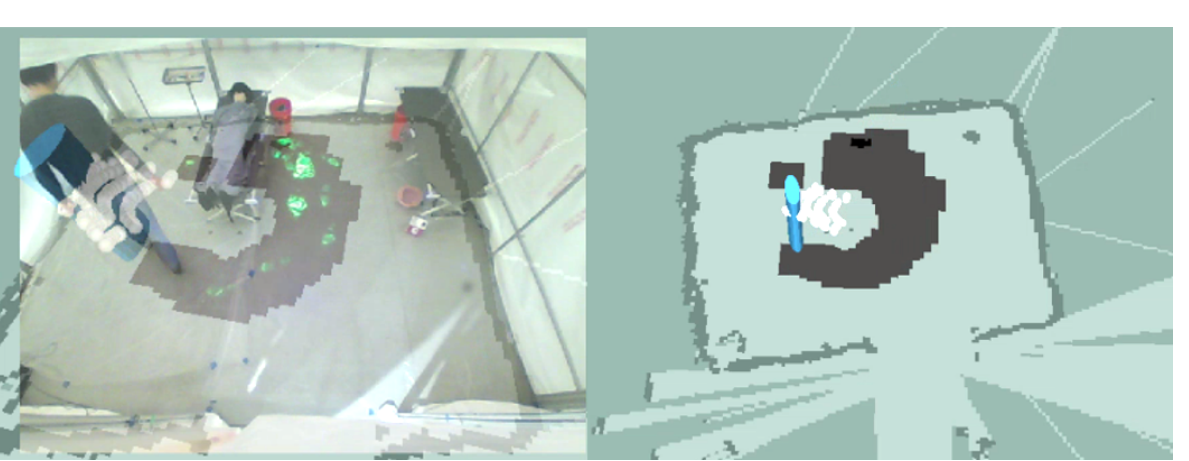
Figure 2. ( Left ): Directly detected footprints (green) and modeled areas of contamination (grey) overlaid on the camera image of the ETU. ( Right ): Visualization of the tracked person and modeled contamination.